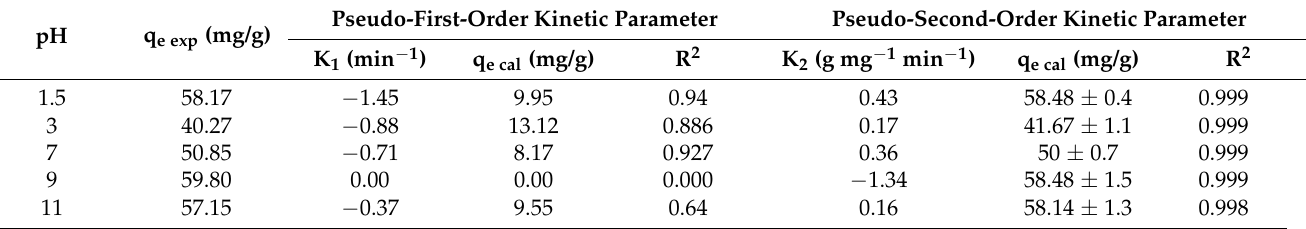
Table 3. The calculated parameters of the pseudo-first-order and pseudo-second-order kinetic model for various pH values.